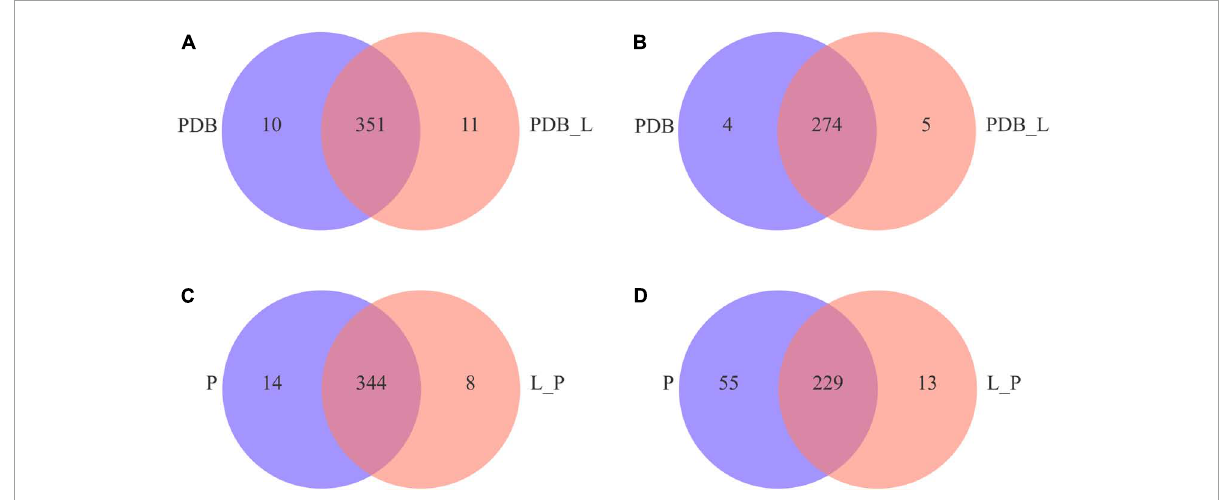
FIGURE5 Venn diagrams of positive (A,C) and negative (B,D) ion modes of differential metabolites in PDB_L vs. PDB and L_P vs. P groups.